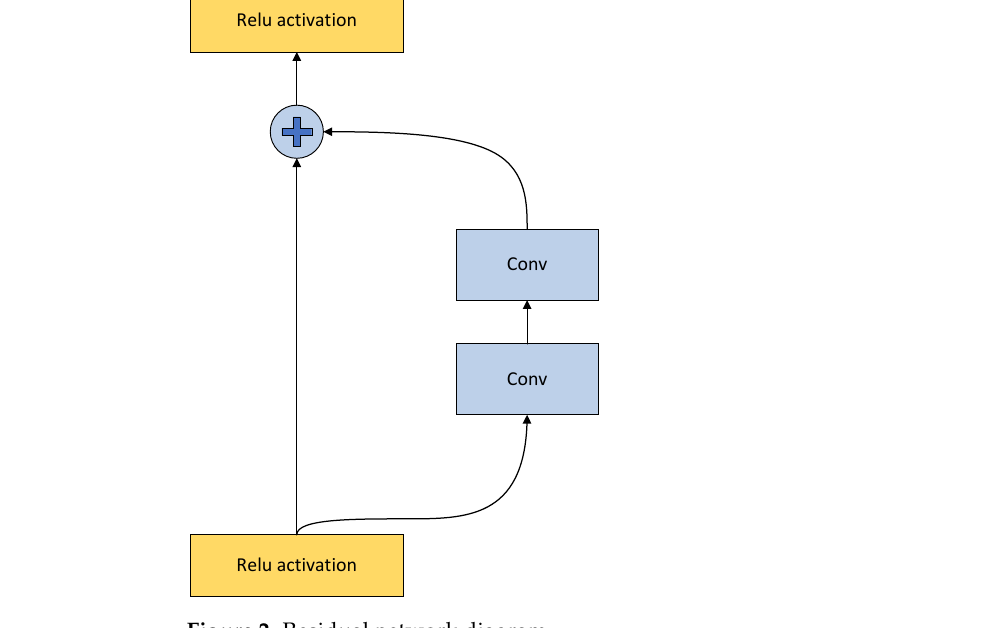
Figure 2. Residual network